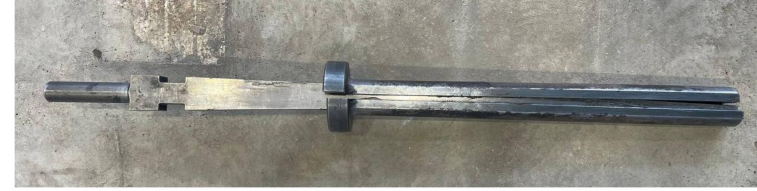
Figure 5. A wedge-shaped element used to open a crack in the base.